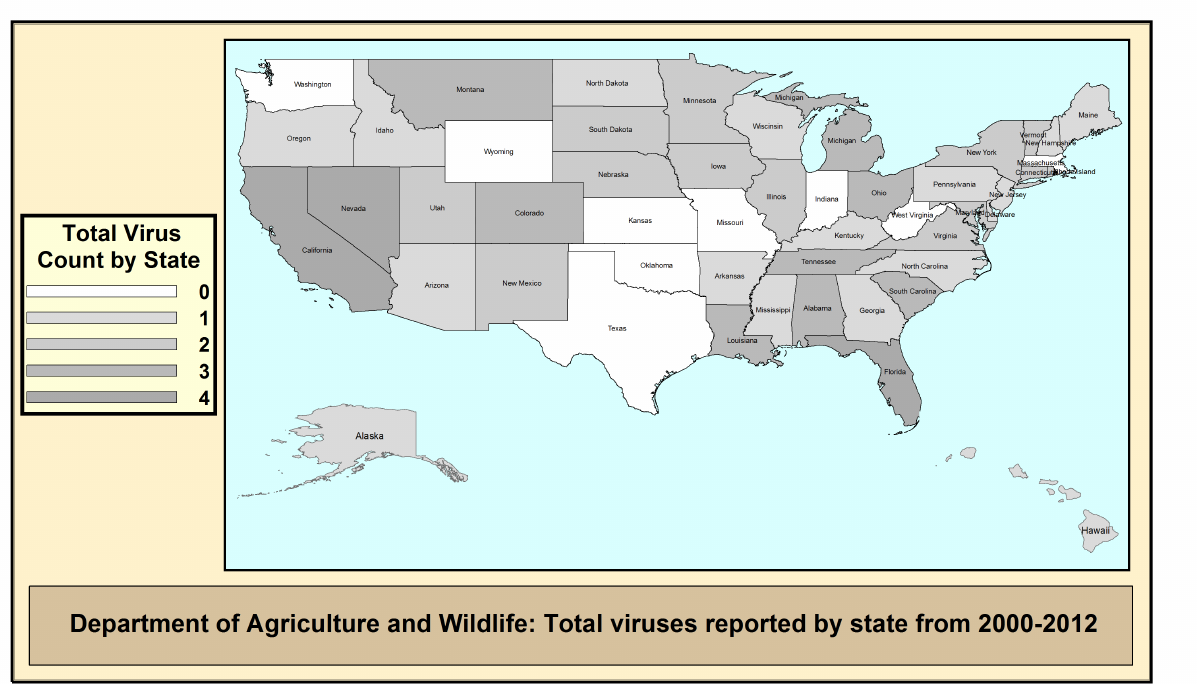
Figure 4. Map of the number of online virus data at agriculture and wildlife